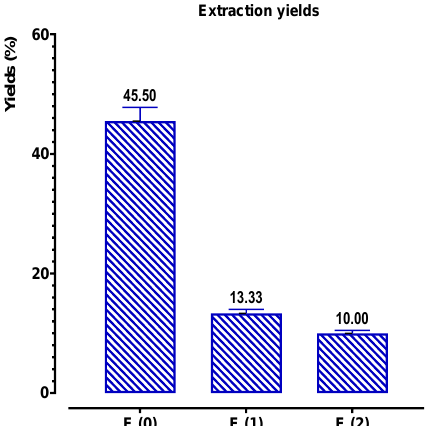
Figure 3. Extraction yields of phenolic compounds from C. sativus.